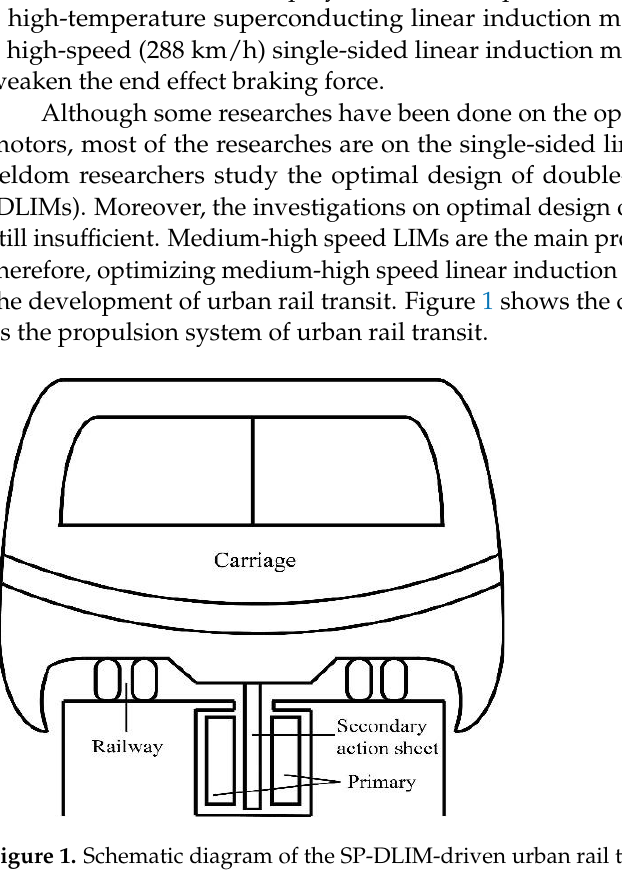
Figure 1. Schematic diagram of the SP-DLIM-driven urban rail transit.